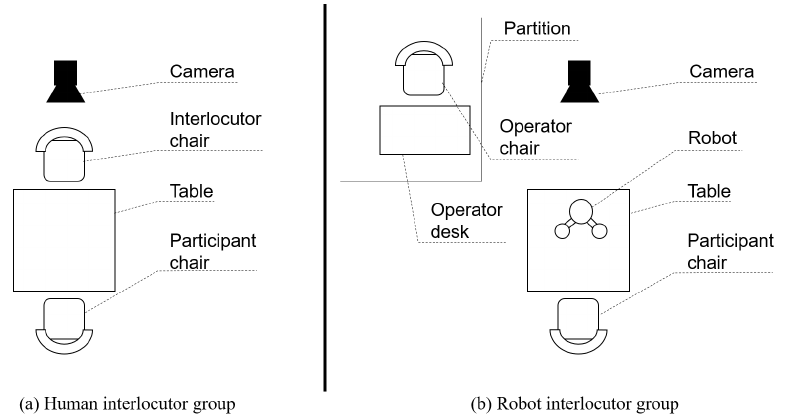
Figure 3. Experimental environment of the human interlocutor group ( a ) and the robot interlocutor group ( b